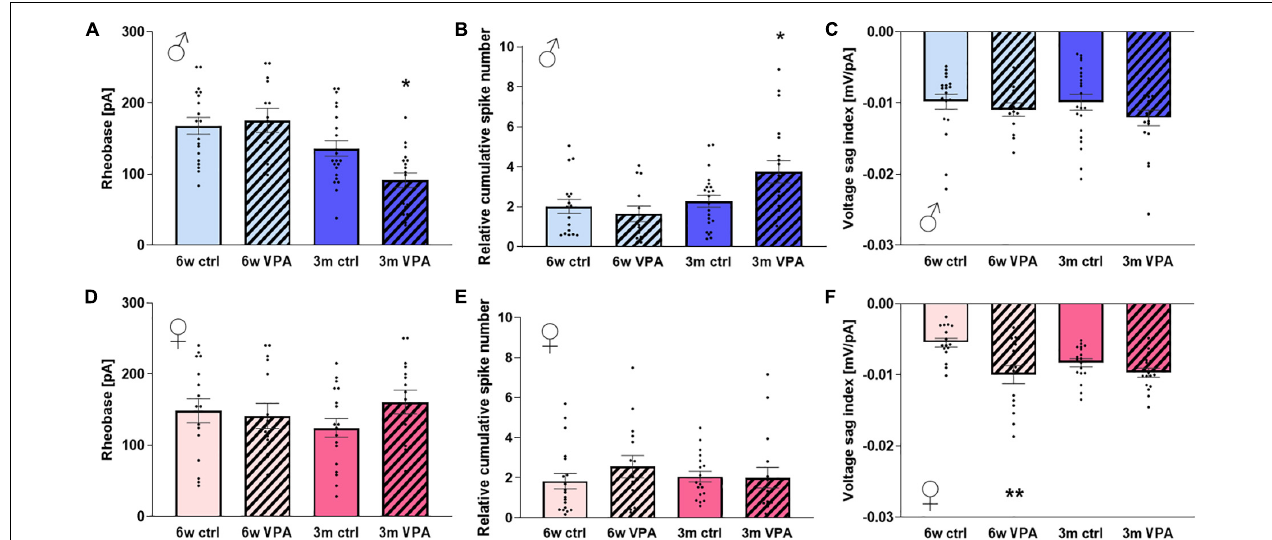
FIGURE 3 | The alterations in the membrane properties of CA1 pyramidal neurons of 6-week-old and 3-month-old rats of both sexes exposed to VPA prenatally compared to the control. (A) The average rheobase and (B) cumulative spike number as a function of the input current and (C) voltage sag index in males. (D) The average rheobase and (E) cumulative spike number as a function of the input current and (F) voltage sag index in females. Data are expressed as mean and S.E.M. Statistical analysis: one-way ANOVA; * significant difference compared to control group; *: p < 0.05; **: p <